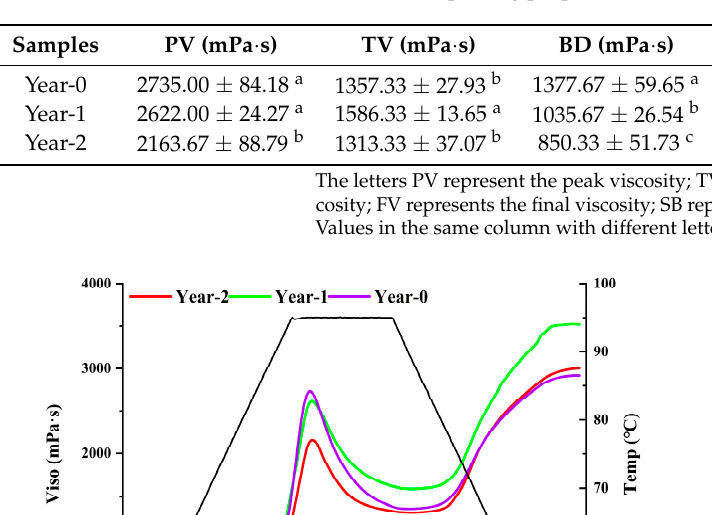
Table 4. Rice pasting properties variation in storage.